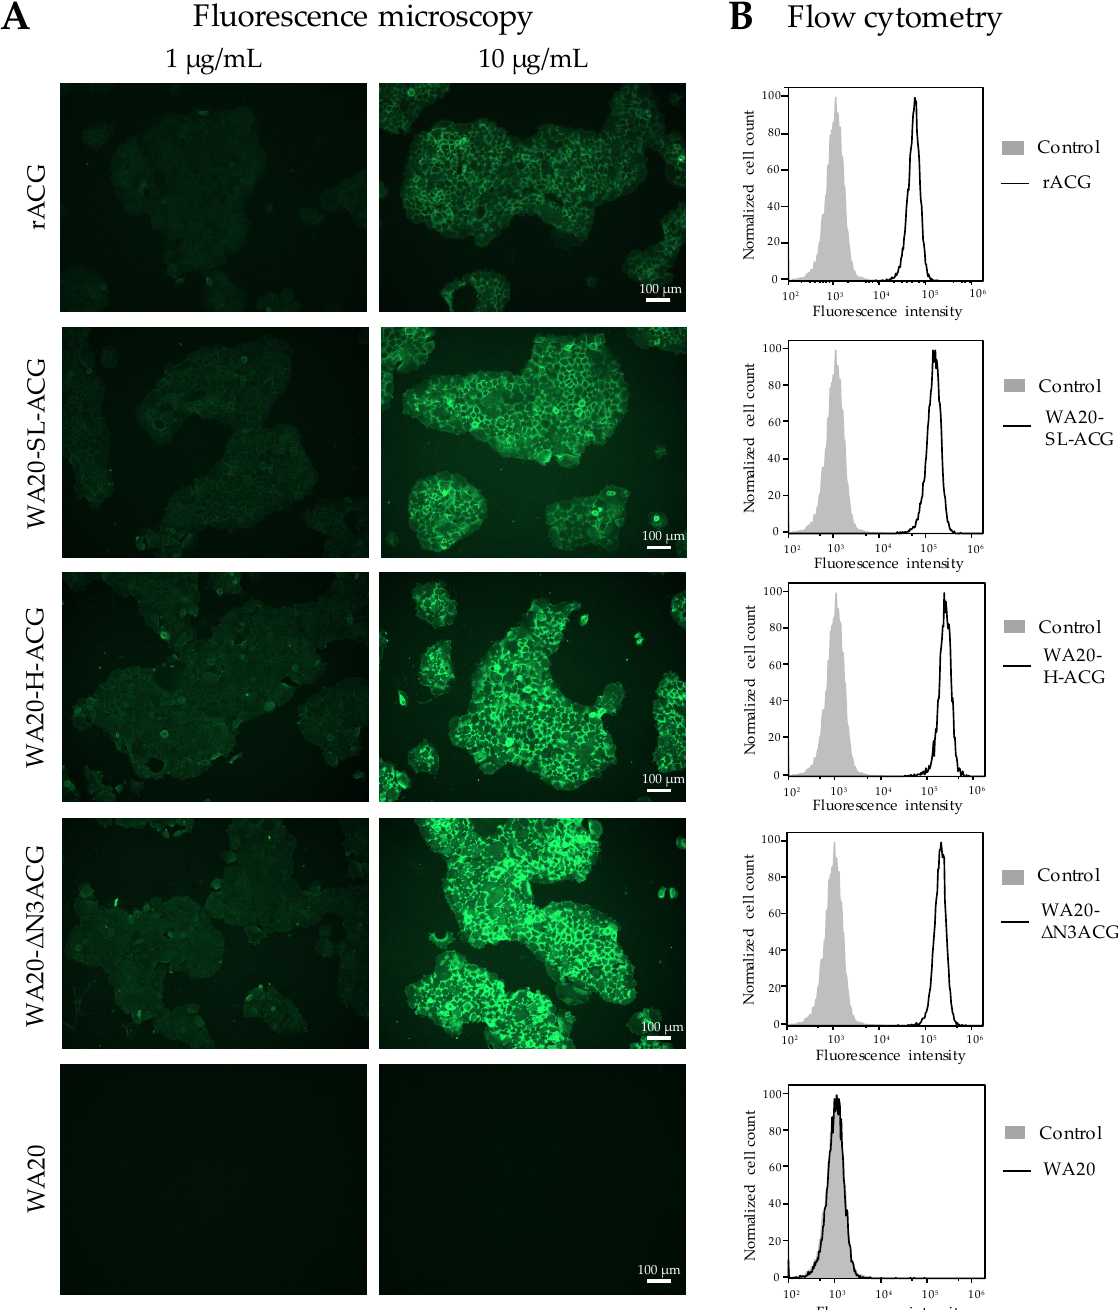
Figure 6. Cell staining experiments. ( A ) Fluorescence microscopy images. BxPC-3 cells of a human pancreatic cancer cell line were stained with the fluorescein-labelled samples of lectin nano-blocks, rACG, and WA20. ( B ) Flow cytometry results. The experiments were performed on BxPC-3 cells. The histogram of each sample is shown with a black line. The negative control, fluorescein isothiocyanate (FITC)-labelled bovine serum albumin (BSA), is shown in the gray area.